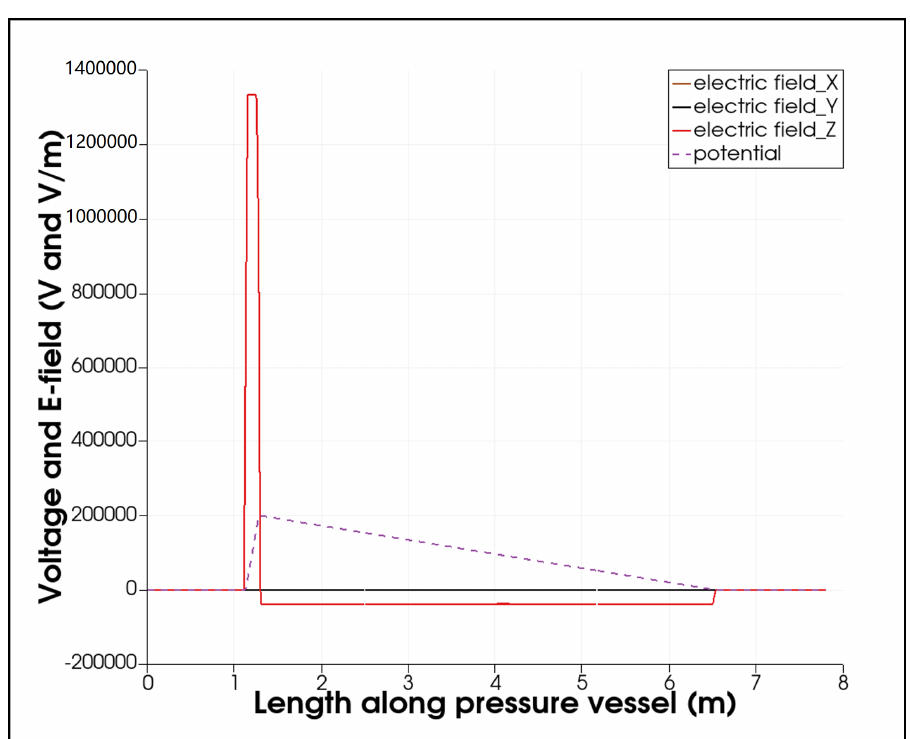
Figure A5. Plot of voltage and fields through the central axis of the TPC for the single-anode design.